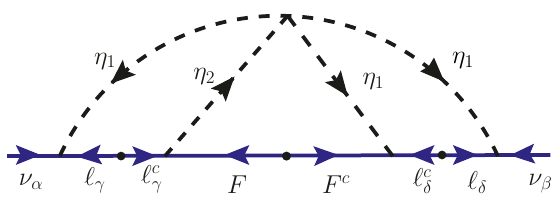
Figure 56 . Three-loop neutrino mass generation with SU(2) L -singlet scalar and fermion (cid:12)elds [55], which induces operator O 9